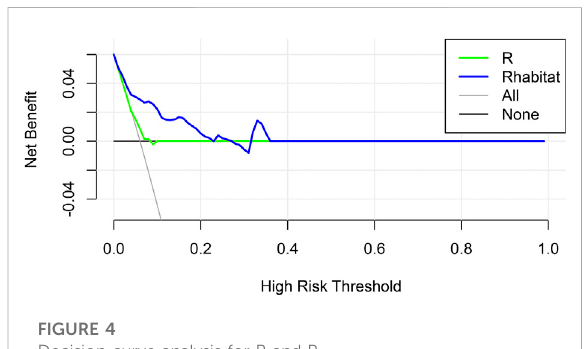
FIGURE 4 Decision curve analysis for R and R habitat .